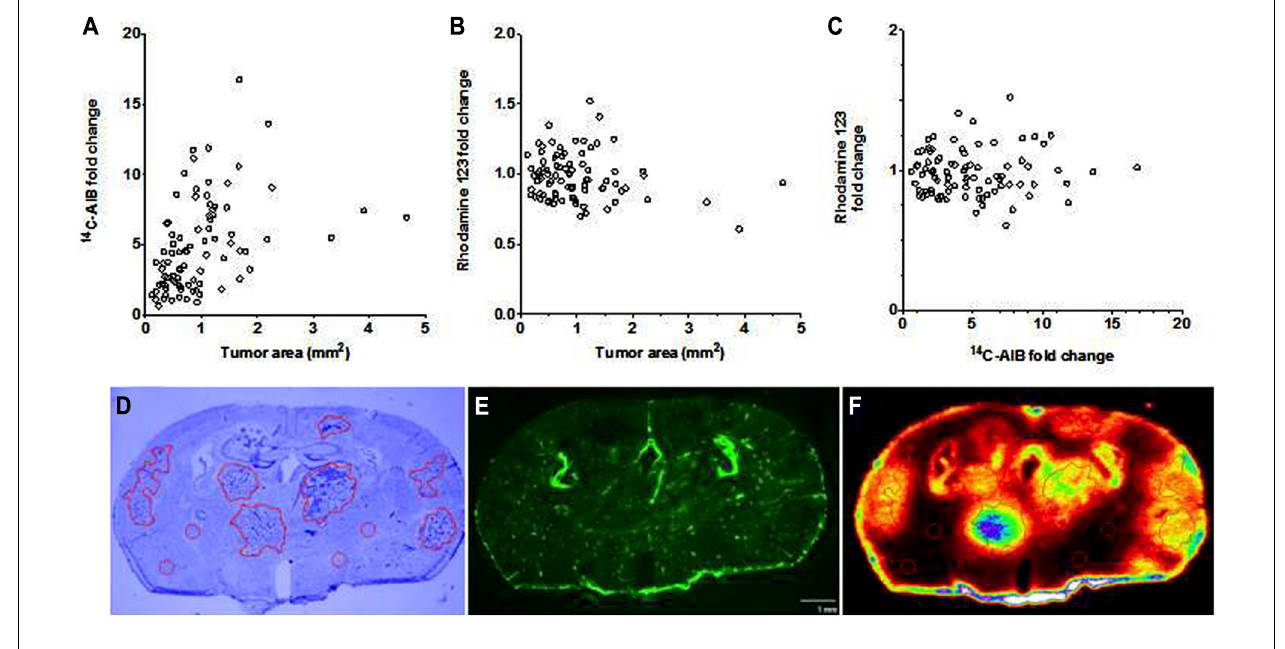
FIGURE 3 |The BTB is variably compromised for compounds entering via passive diffusion but retains P-gp mediated efflux. The passive permeability marker 14 C-AIB fold change in brain metastases did not correlate ( r 2 = 0.167) with metastasis size (mm 2 ) (A) . R123 fold change in brain metastases did not correlate ( r 2 = 0.033) with metastasis size (B) .There was